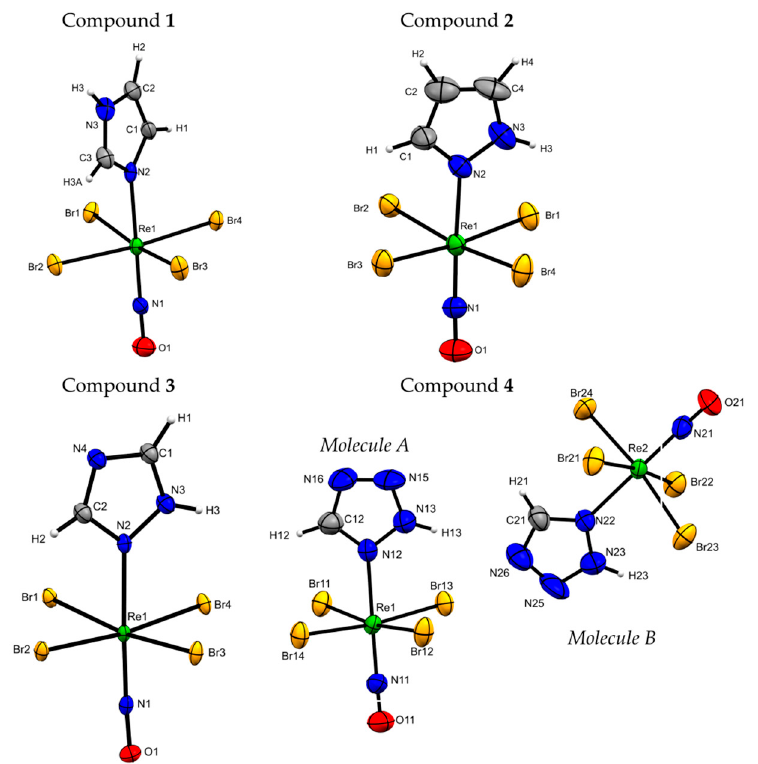
Figure 1. Perspective drawings of 1 – 4 showing the atom numbering. Thermal ellipsoids are plotted at a 30% probability level. The Bu 4 N + cation was omitted for clarity. A and B stand for the two crystallographically independent complex anions in 4